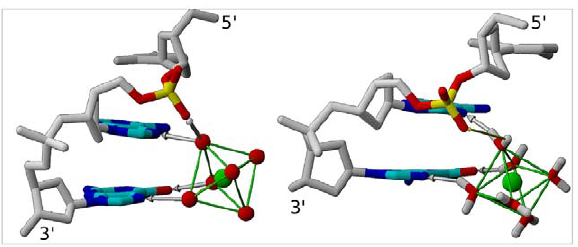
Figure 1. Interaction of Mg 2 + in the DNA major groove. The 5 9 - CpApG-3 9 fragment binds Mg 2 + in both crystallographic (left) and simulated (right) structures. Mg 2 + (green) forms water-mediated hydrogen bonds (gray arrows) with the N7 of both purines and the O6 of the guanine via its first hydration shell (left: oxygen atoms in red; right: explicit water molecules). The phosphate groups of CpA and ApG are in BII and BI conformation, respectively. Owing to the orientation of the O2P-O1P vector in the BII-CpA linkage, an additional hydrogen bond occurs between Mg 2 + and O2P (left) in several X-ray structures. For the same reason, Mg 2 + remains close to O2P in the simulated structures (right, thin yellow arrow).